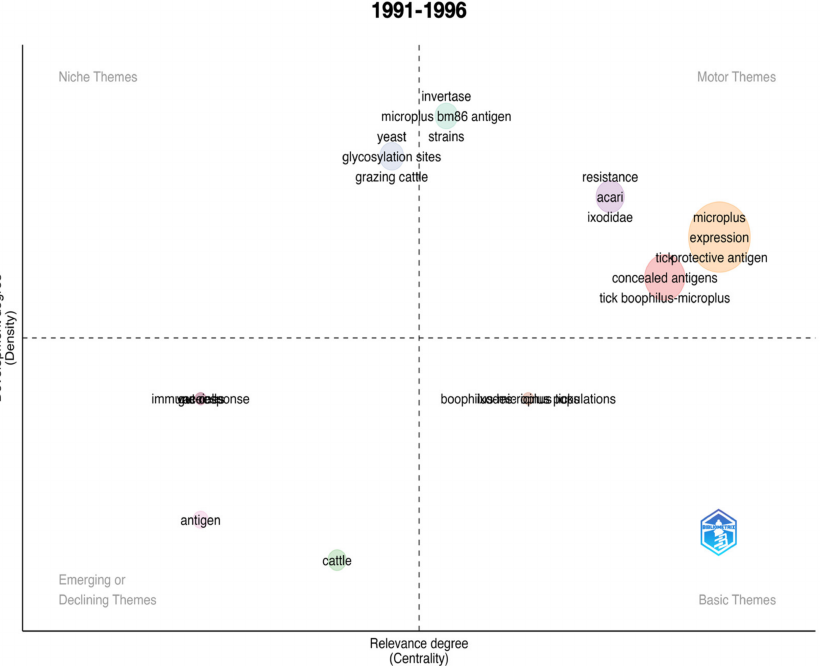
Figure 2. Thematic roles of the documents published on the topic “anti–tick vaccination” in the period